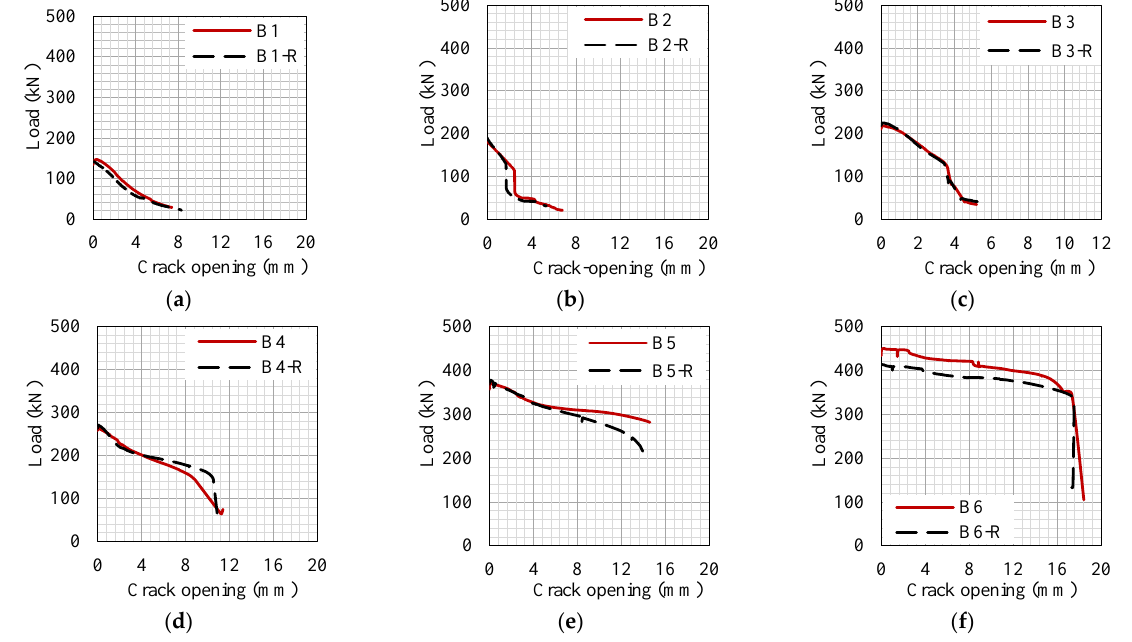
Figure 13. Load crack opening responses of ( a ) B1, ( b ) B2, ( c ) B3, ( d ) B4, ( e ) B5, and ( f ) B6.